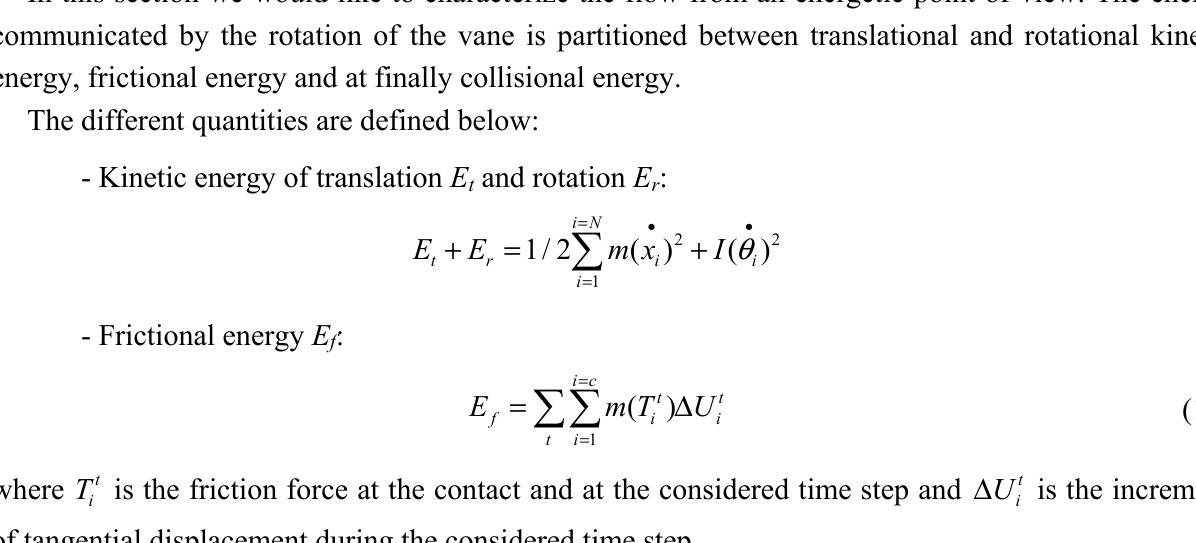
and the kinetic f